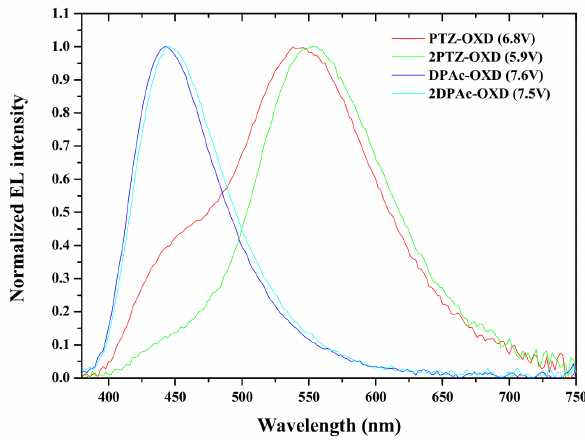
Figure 6. Normalized electroluminescent (EL) spectra of Device